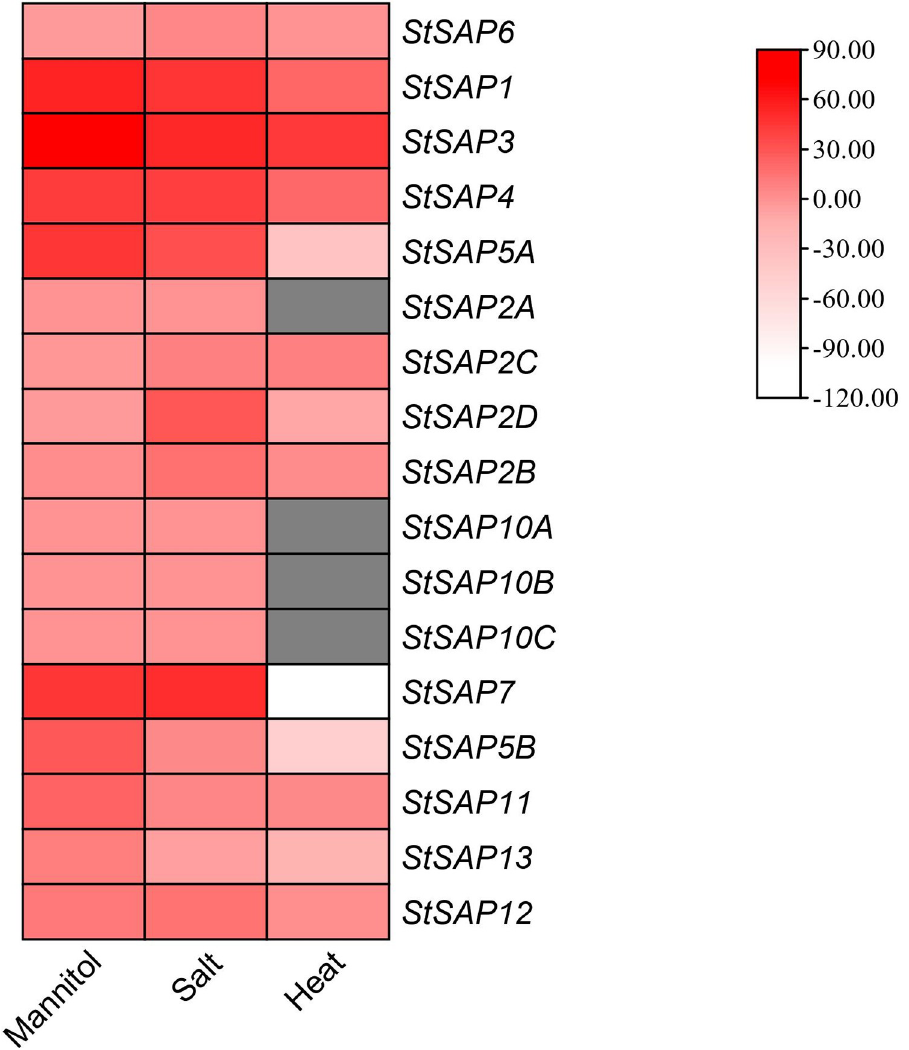
Fig 6. Expression analysis of StSAP genes under mannitol, salt, and